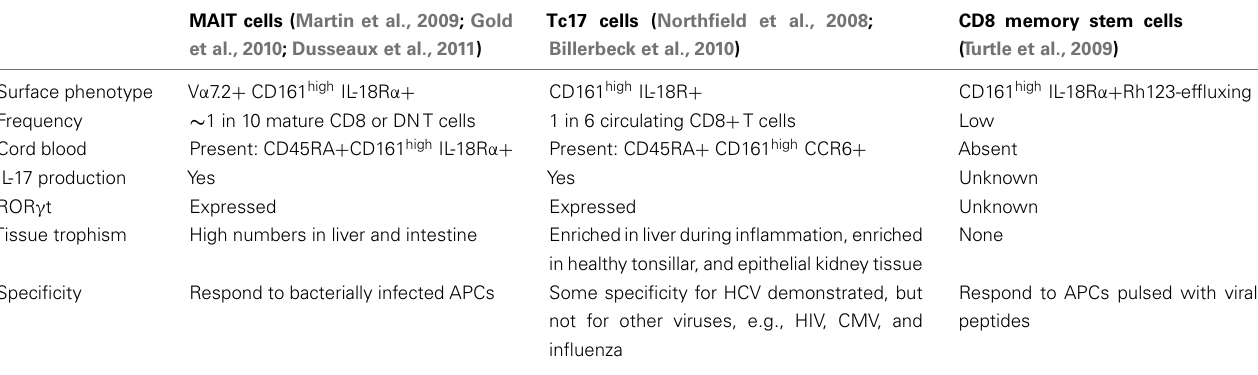
Table 1 |Three parallel characterizations of CD161 high CD8 + T